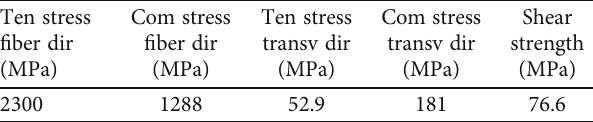
Table 5: T300/epoxy composite properties [9, 10].